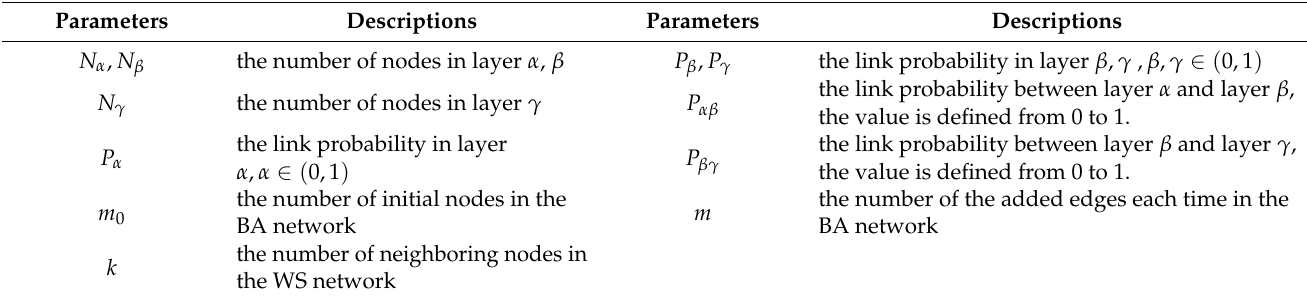
Table 1. Three-layer complex network model